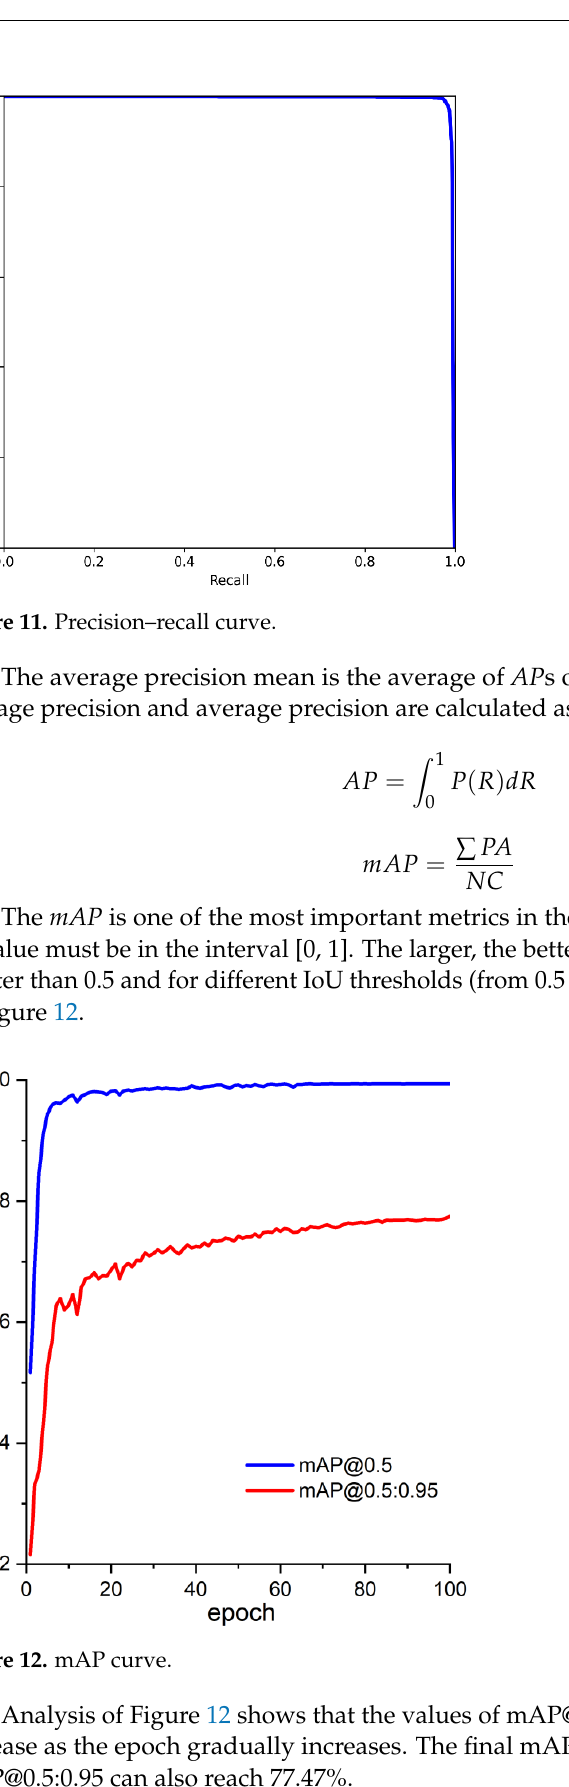
Figure 12. mAP curve.